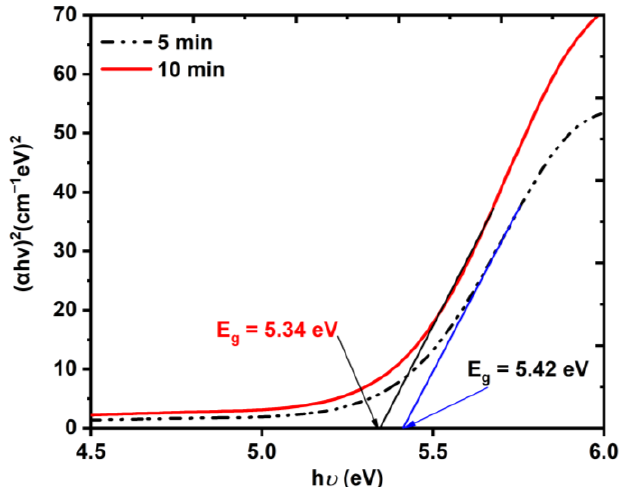
Figure 6. The energy bandgap of the Au NP thin film using the Tauc